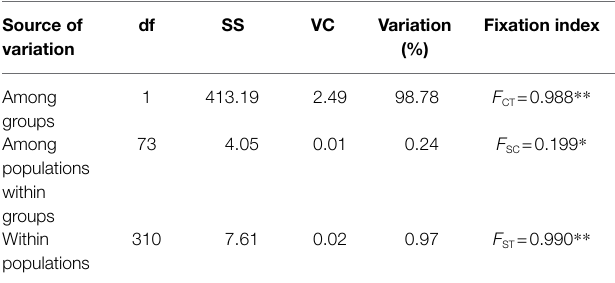
TABLE 3 | Hierarchical analyses of molecular variance (AMOVAs) based on chloroplast (cp) DNA haplotype frequencies of Toxicodendron vernicifluum. Source of